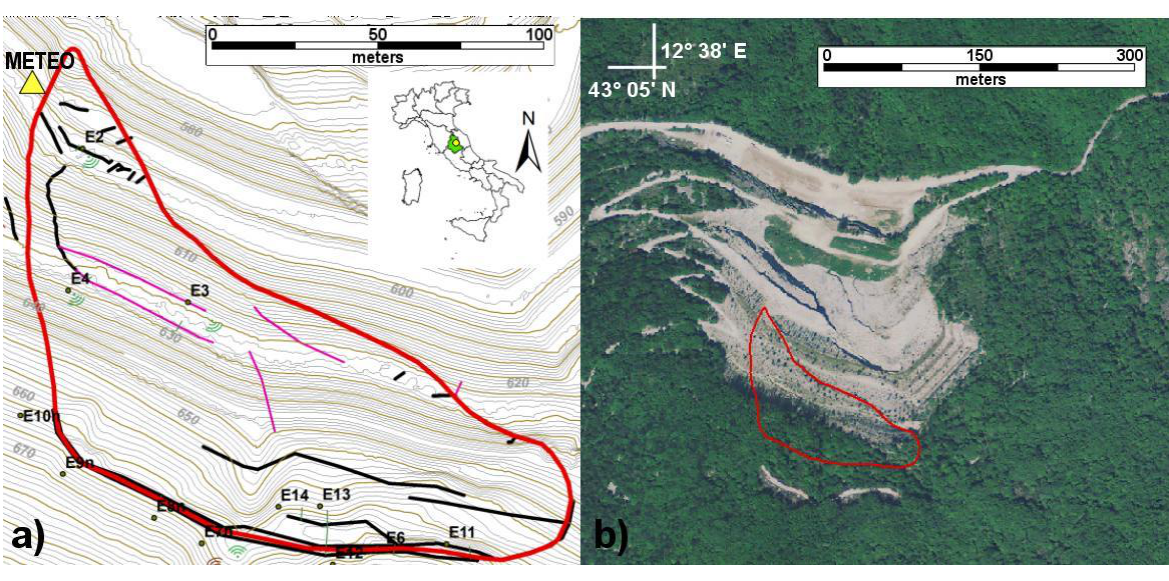
Figure 1. ( a ) Map of the Torgiovannetto landslide area (contour lines = 2 m) with tracers of the major discontinuities, the boundary of the landslide, the location of the extensometer network (E) and the meteorological station (METEO). ( b ) Aerial view of the